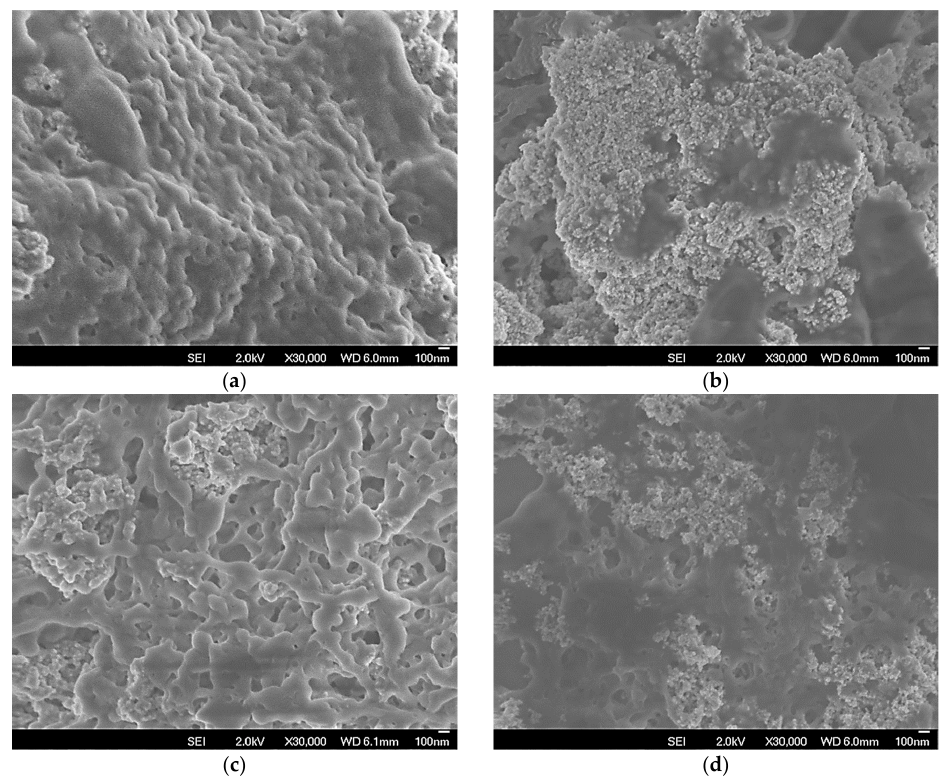
Figure 11. SEM-FEG images of pm-CLEAs of porcine pancreas lipase co-aggregated with ( a ) SMNPs and bovine serum albumin (pm-BSA-CLEA), ( b ) SMNPs and soy protein (pm-SP-CLEA), followed by treatment with α -amylase ( c , d , respectively). All CLEAs were prepared under the same conditions, the only difference is if the starch (pore-making agent) was not hydrolyzed ( a , b ) or was hydrolyzed ( c , d ) with α